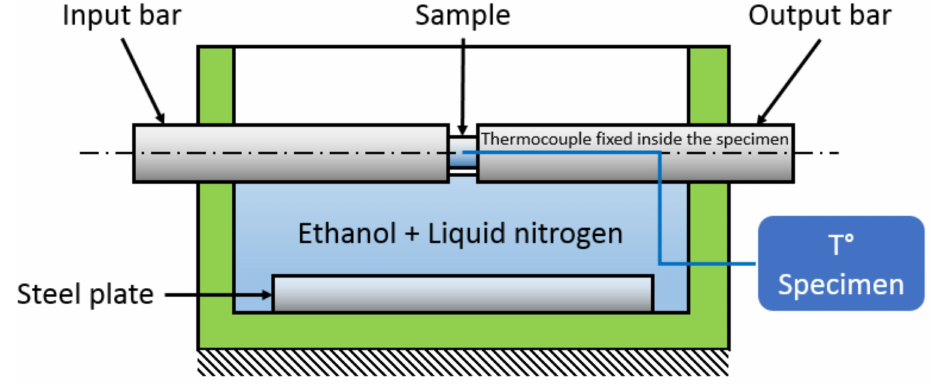
Figure 3. Description of the technique used to perform dynamic compression at low temperature.